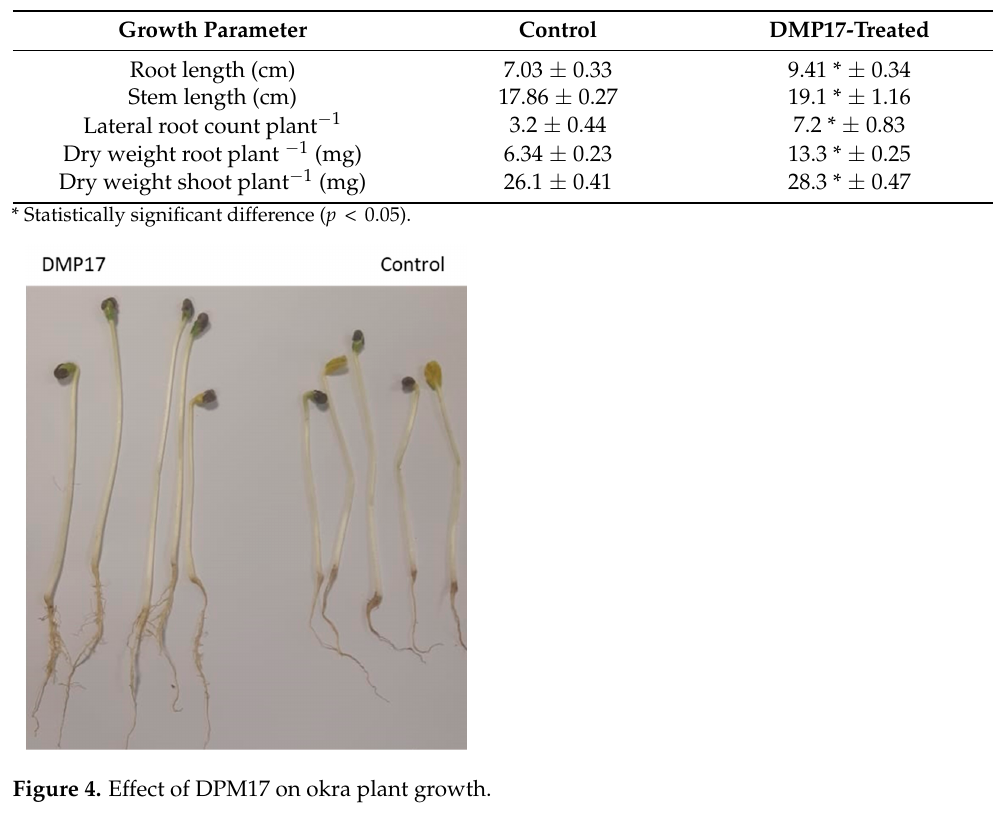
Figure 3. DPM17 growth on Jensen’s N ‐ free medium.